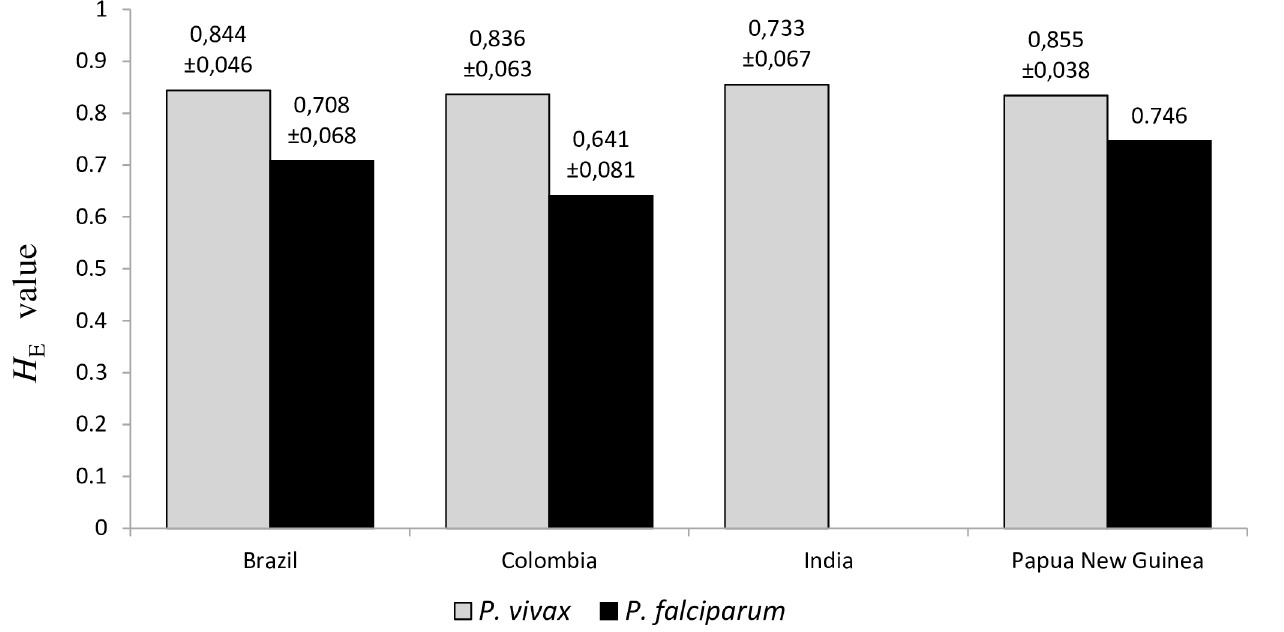
Fig 2. Genetic diversity ( H E ) of analyzed P . vivax and P . falciparum populations.